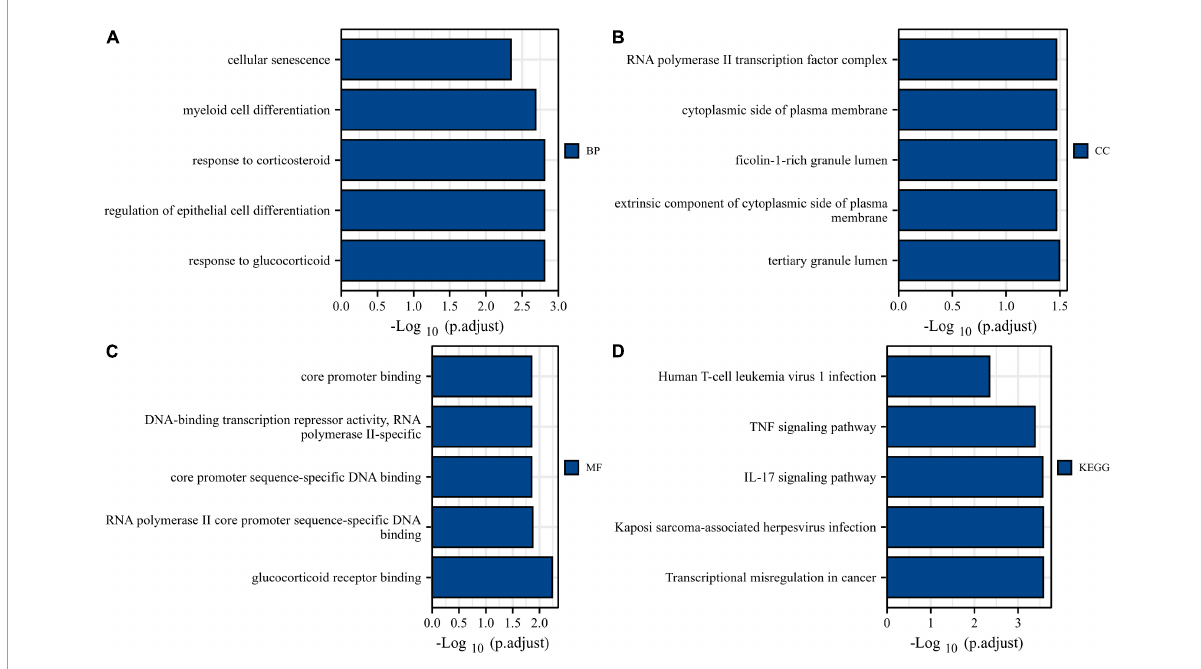
FIGURE5 Bar plots of 14 DESRG-enriched GO terms and KEGG pathways. Panels (A–D) represent BP, CC, MF, and KEGG, respectively. GO, Gene Ontology; KEGG, Kyoto Encyclopedia of Genes and Genomes; BP, biological process; CC, cellular component; MF, molecular function; DESRGs, differentially expressed senescence-related